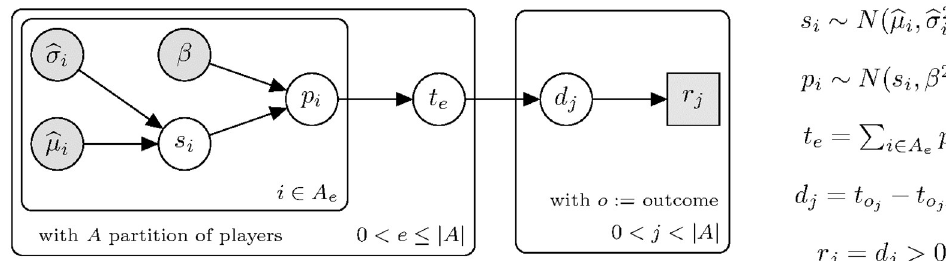
Fig 10. Bayes network of TrueSkill